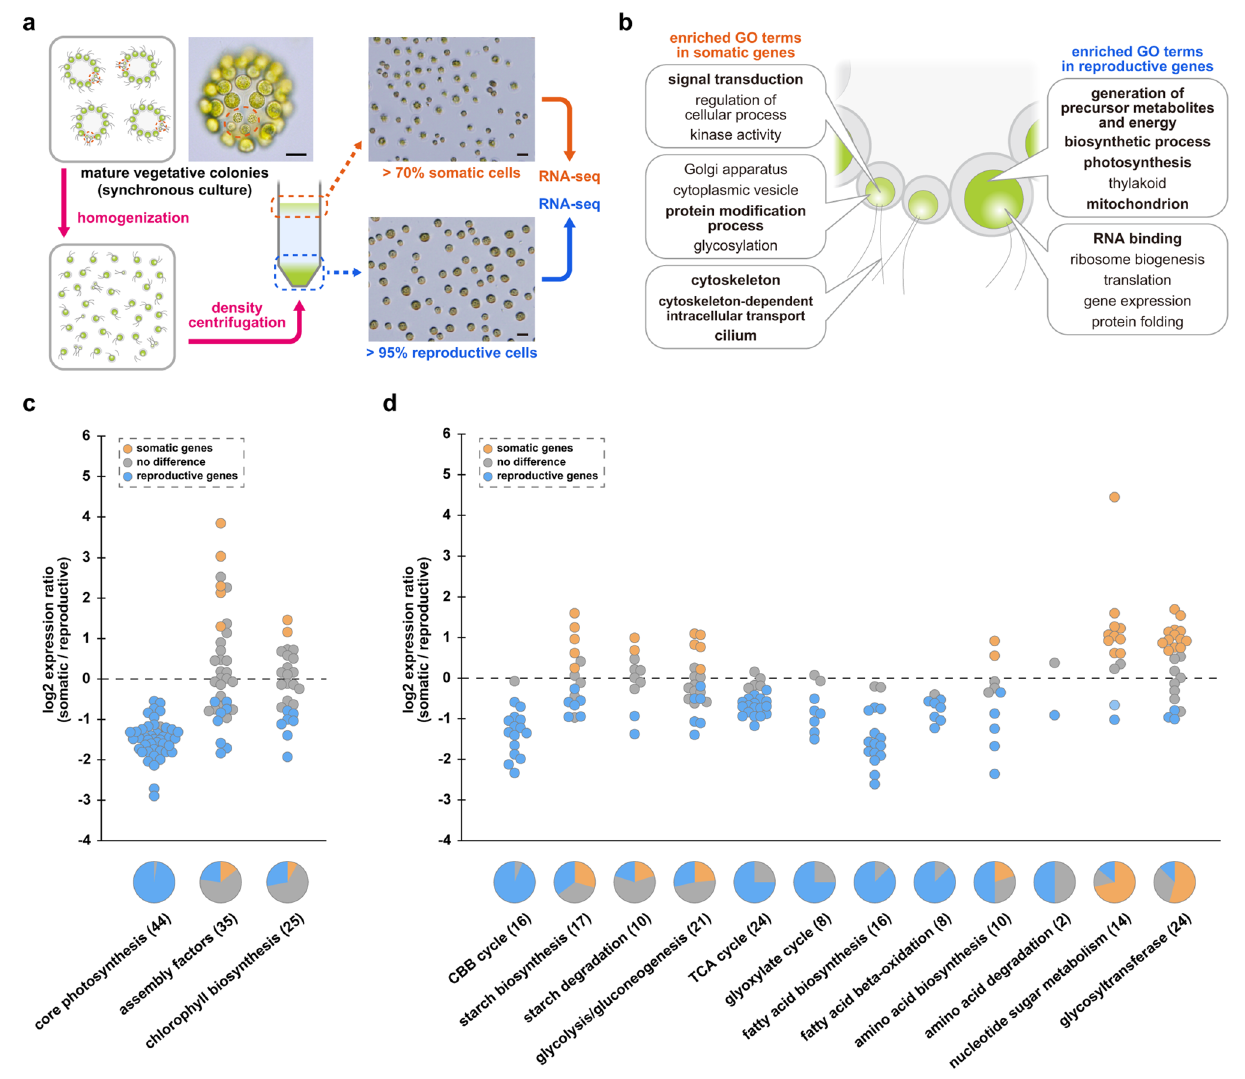
cells and small somatic cells (orange dotted circles). By homogenization and density centrifugation of vegetative colonies, somatic cell and reproductive cells were separated and then subjected to RNA extraction for RNA-seq. Scale bars = 20 μm. ( b ) The representative enriched terms in somatic and reproductive genes by GO enrichment analysis. Bold texts indicate the GO terms also enriched in somatic and gonidial genes in Volvox carteri 32 . All other enriched GO terms were listed in Supplementary Table 3. ( c ) Gene expression ratio of photosynthesis- related genes (Supplementary Data 5). The number in brackets indicates the number of genes in each category. ( d ) Gene expression ratio of the major carbon metabolic pathways (Supplementary Data 6), nucleotide sugar metabolism and glycosyltransferases (Supplementary Data 7). The number in brackets indicates the number of genes in each